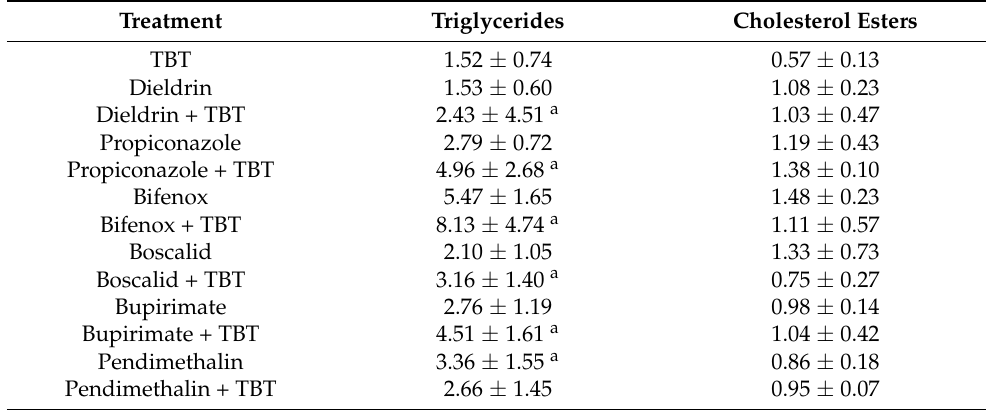
Table 4. Effects of pesticide treatments on triglycerides and cholesterol esters. Triglycerides and cholesterol esters expressed in fold change of DMSO group (mean ± standard error). “a” indicates significant difference with DMSO. p < 0.05 is considered significant according to one-way ANOVA test followed by Tukey’s multiple comparisons